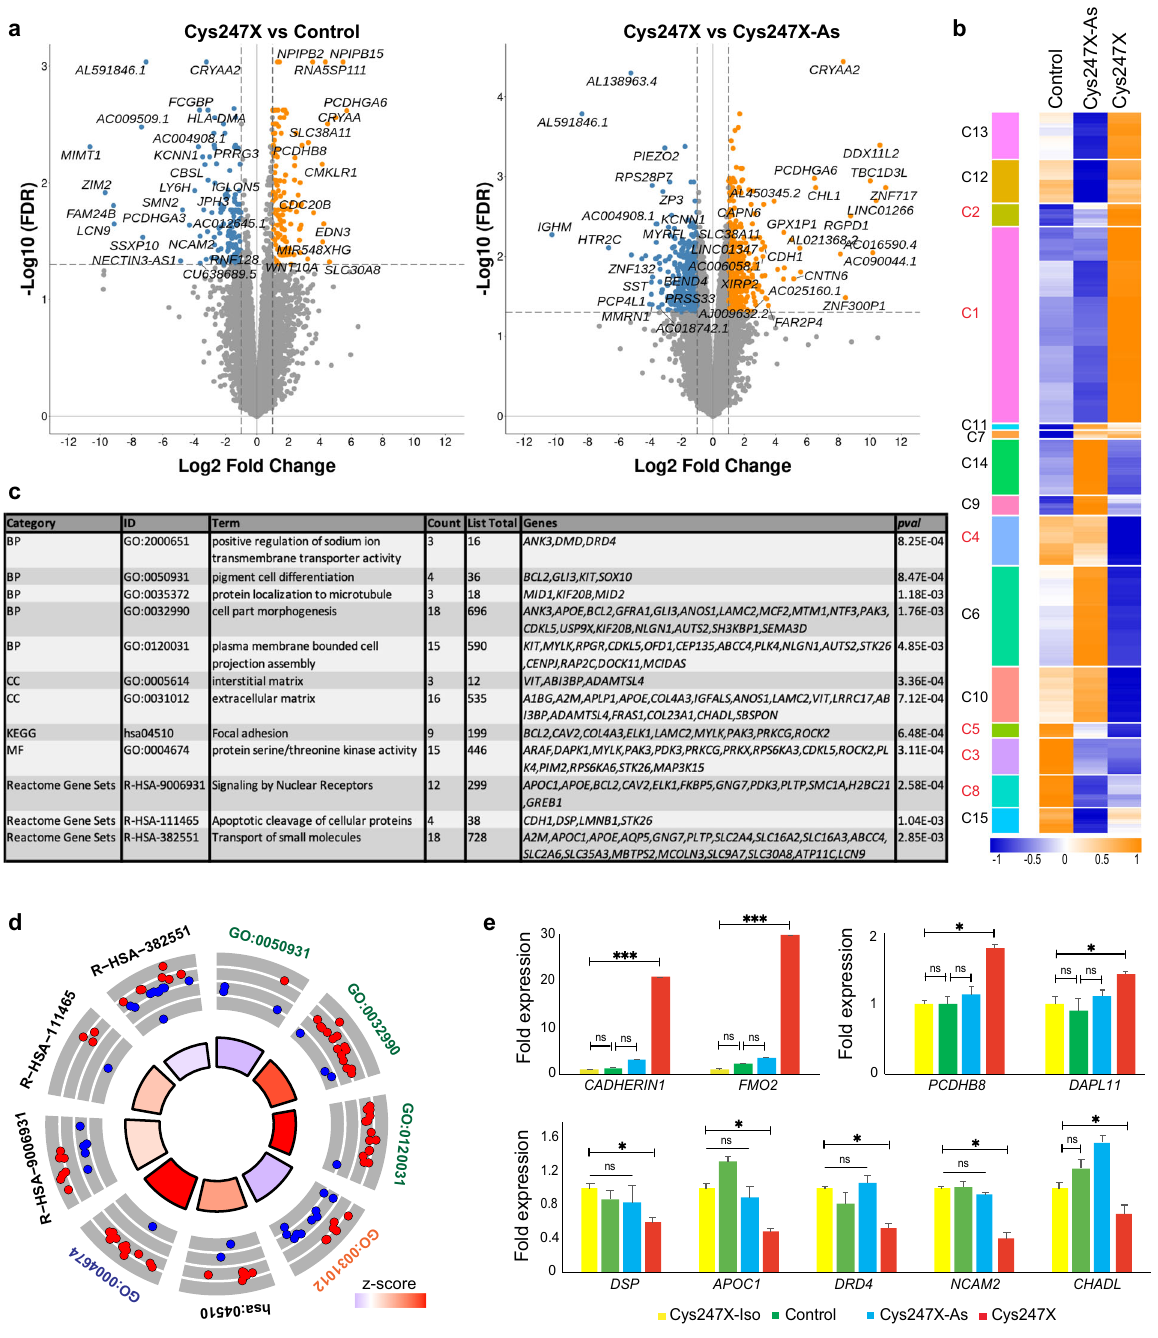
Fig. 8 Identi fi cation of genes and pathways deregulated in hiPSC-derived RPE cells from PRPF31 patients using whole transcriptome analysis. a Volcano plots of differentially expressed genes for Cys247X vs Control (left panel) and Cys247X vs Cys247X-As (right panel). Difference in gene expression (FC) is plotted on the x-axis (log2 scale), and False Discovery Rate (FDR) adjusted signi fi cance is plotted on the y-axis (log10 scale). Genes signi fi cantly up- or downregulated are indicated in orange and blue, respectively. b Hierarchical clustering analysis of the DEGs between all groups with genes up- or downregulated by a factor ≥ 2 with FDR ≤ 0.05 between Control, Cys247X-As and Cys247X patient-derived iRPE cells. The z score was derived from the average of the triplicates for each experimental group. Blue: low expression; orange: high expression. The left column represents the 15 clusters, and selected clusters used for further pathway analysis are in red. c Table of the over-represented GO pathways of interest identi fi ed with Metascape using the DEGs from the selected clusters. The different categories of pathways are BP, Biological Process; CC, Cell Compartment; KEGG, Kyoto Encyclopedia of Genes and Genomes; MF, Molecular Function. d Circular visualization of selected GO enriched pathways. Down- (blue dots) and up-regulated genes (red dots) within each GO pathway are plotted based on logFC. z score bars indicate if an entire biological process is more likely to be increased or decreased based on the genes it comprises. Green, Biological Process; orange, Cell Compartment; blue, Molecular Function. e Differential expression analysis by RT-qPCR of CADHERIN1 , FMO2 , PCDHB8 , and DAPL11 (upper panel) and of DSP , APOC1 , DRD4 , NCAM2, and CHADL (lower panel) in Cys247X-Iso, Control, Cys247X-As and Cys247X iRPE cells. Fold expression is relative to Cys247X-Iso. Values are mean ±SD, n = 3 samples of 1×10 6 iRPE cells from N = 3 independent differentiations. Data were normalized against the geometric average Δ Ct of the 18S housekeeping gene. Statistical signi fi cance assessed using the Kruskal – Wallis test (* P <0.05; *** P